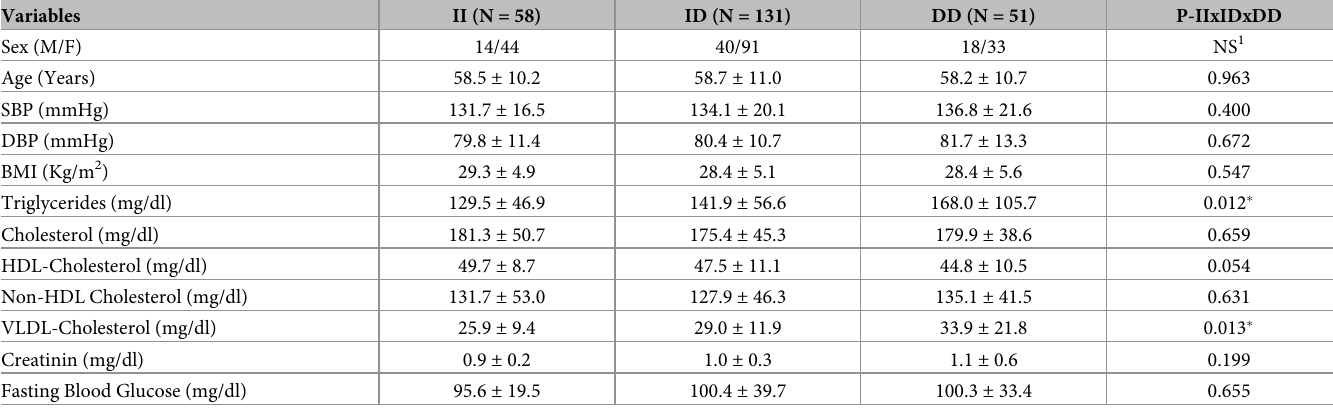
Table 6. Analysis of the influence of ACE I/D polymorphism on clinical-laboratory variables among case + control individuals. Variables